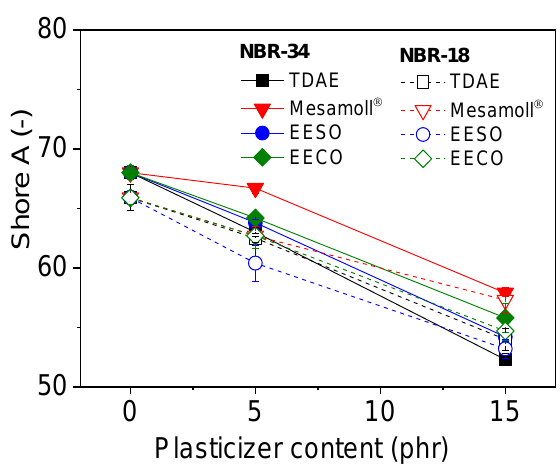
Figure 7. Shore A hardness values as a function of plasticizer content for NBR vulcanizates.